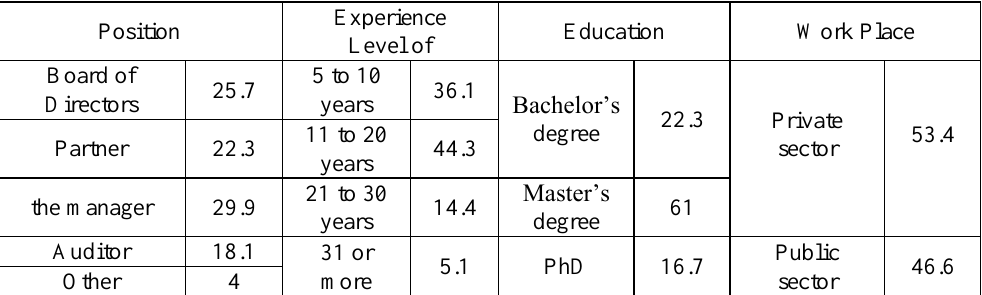
Table 1. Demographic characteristics of